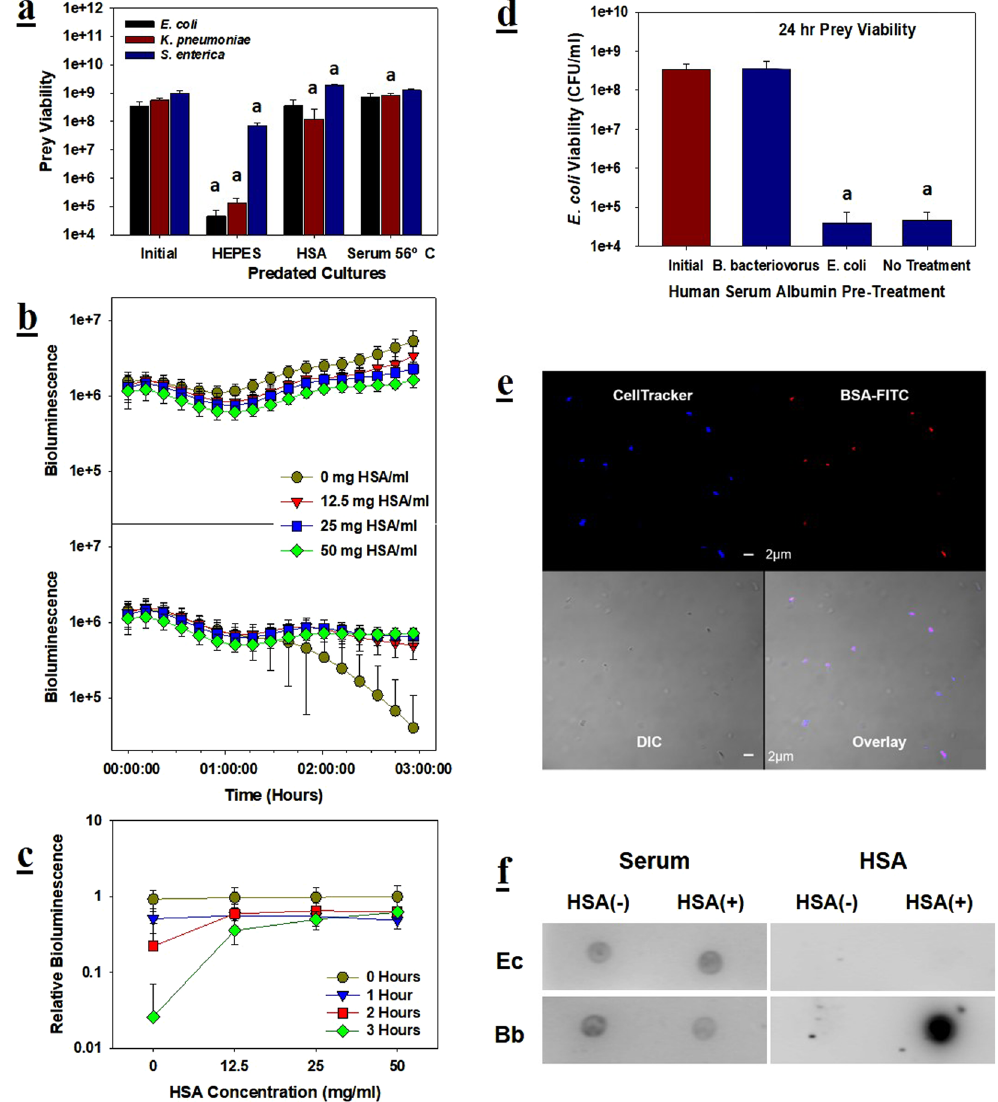
Figure 3. Serum albumin binds to and prevents the predator from attacking its prey. ( a ) The addition of human serum albumin (HSA) to HEPES buffer at a physiologically relevant concentration of 50 mg/ml significantly inhibits predation of all three prey strains. For comparison, predation tests were also attempted in heat-treated serum. The initial PPR was approximately 0.05 and the significance was determined by comparing the viabilities obtained after 24 hours with the initial values. p < 0.001 for a; p < 0.01 for b. n = 3. ( b ) Serum albumin prohibits predation of a bioluminescent E. coli prey strain. The bioluminescence (BL) from the prey strain was monitored over time while being predated upon in the presence of HSA. The upper panel is the control results, i.e., without B. bacteriovorus HD100 addition, and the bottom panel is with the predator added. The PPR was approximately 9.7 for these experiments. n = 9. ( c) Relative bioluminescence (RBL) results calculated using the data in ( b ). The RBLs were calculated by comparing the BL from the predated sample with that of its control (unpredated) every hour and the data plotted. The results show the similar levels of inhibition obtained with each of the HSA concentrations tested. n = 9. ( d ) Pretreatment of B. bacteriovorus HD100 with serum albumin is sufficient to block predation. The predator or its prey ( E. coli ) was pretreated by incubating it for one hour in a 50 mg/ml HSA solution made with HEPES buffer. Afterwards, the predator (or prey) were pelleted, washed and mixed with fresh prey (or predator) and the predatory activity determined after 24 hours. For comparison, samples containing untreated predator and prey cells were also tested. The significance was determined by comparing the viabilities obtained after 24 hours with the initial values. p < 0.001 for a. n = 3. ( e ) Confocal images of B. bacteriovorus HD100 after exposure to FITC-labeled BSA. B. bacteriovorus HD100 cells in HEPES buffer were incubated with the Cell Tracker live stain for 30 minutes at 30 °C to produce fluorescent predatory cells. After pelleting and washing the cells, they were exposed to FITC-labeled BSA (10 mg/ml) for one hour at 30 °C and 250 rpm. The cells were washed again to remove any free or loosely bound BSA molecules before being imaged using a laser confocal microscope (LX-700, Olympus, USA). This image shows the BSA molecules (red) bound to the predatory cells (blue). Both of the scale bars in the middle indicate 2 μ m. ( f ) Dot blot results